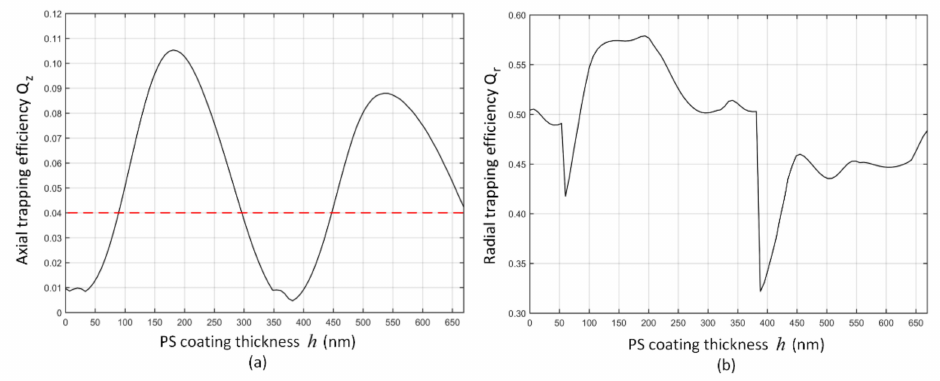
Figure 4. Axial ( a ) and radial ( b ) trapping e ffi ciency for a coated BTG sphere with a core radius of 2.5 µ m, as the PS coating thickness